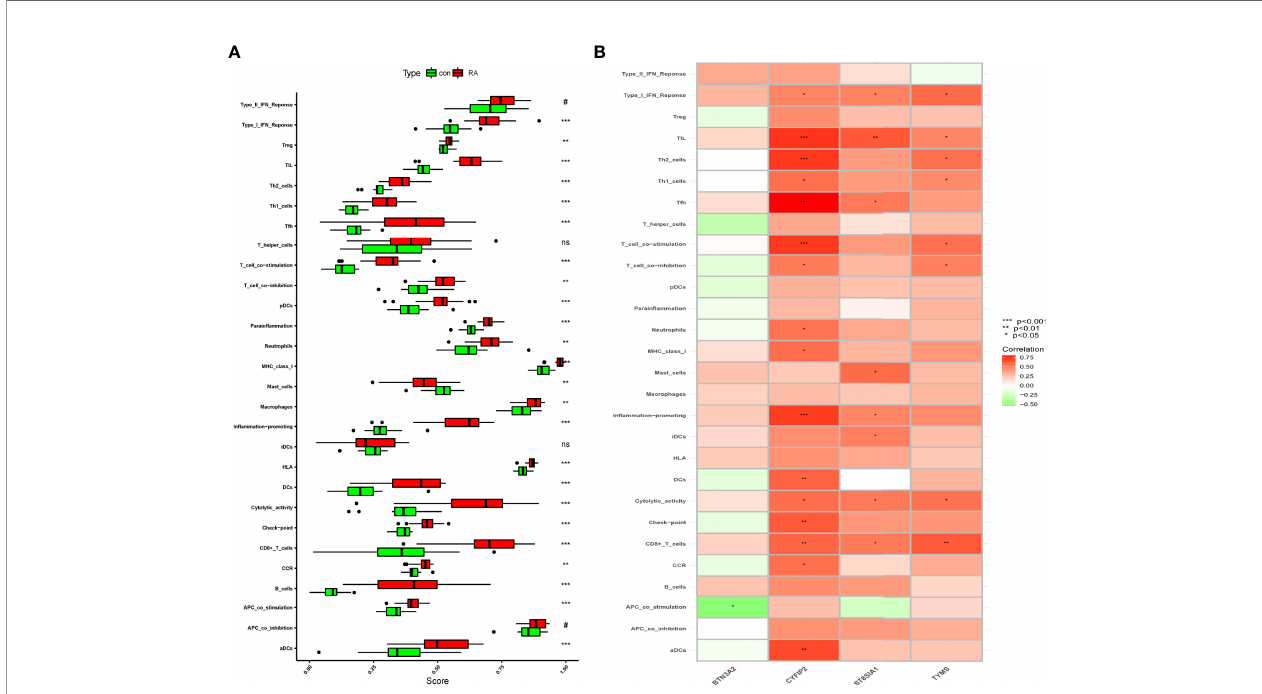
FIGURE 8 | Correlation between RA and immunity. (A) Comparison of ssGSEA scores of immune cells and immune pathways between RA group and healthy controls. (B) Correlation between characteristic genes and immunity. *p < 0.05, **p < 0.01, ***p < 0.001. NS, no signi fi